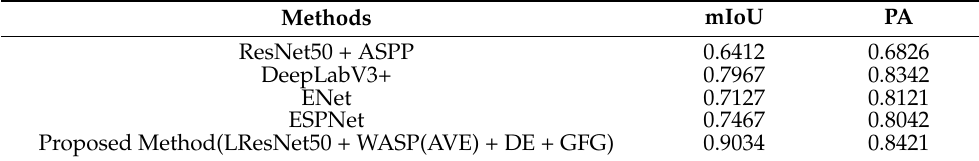
Table 7. Comparison quantitative results of different methods using Inria aerial dataset.